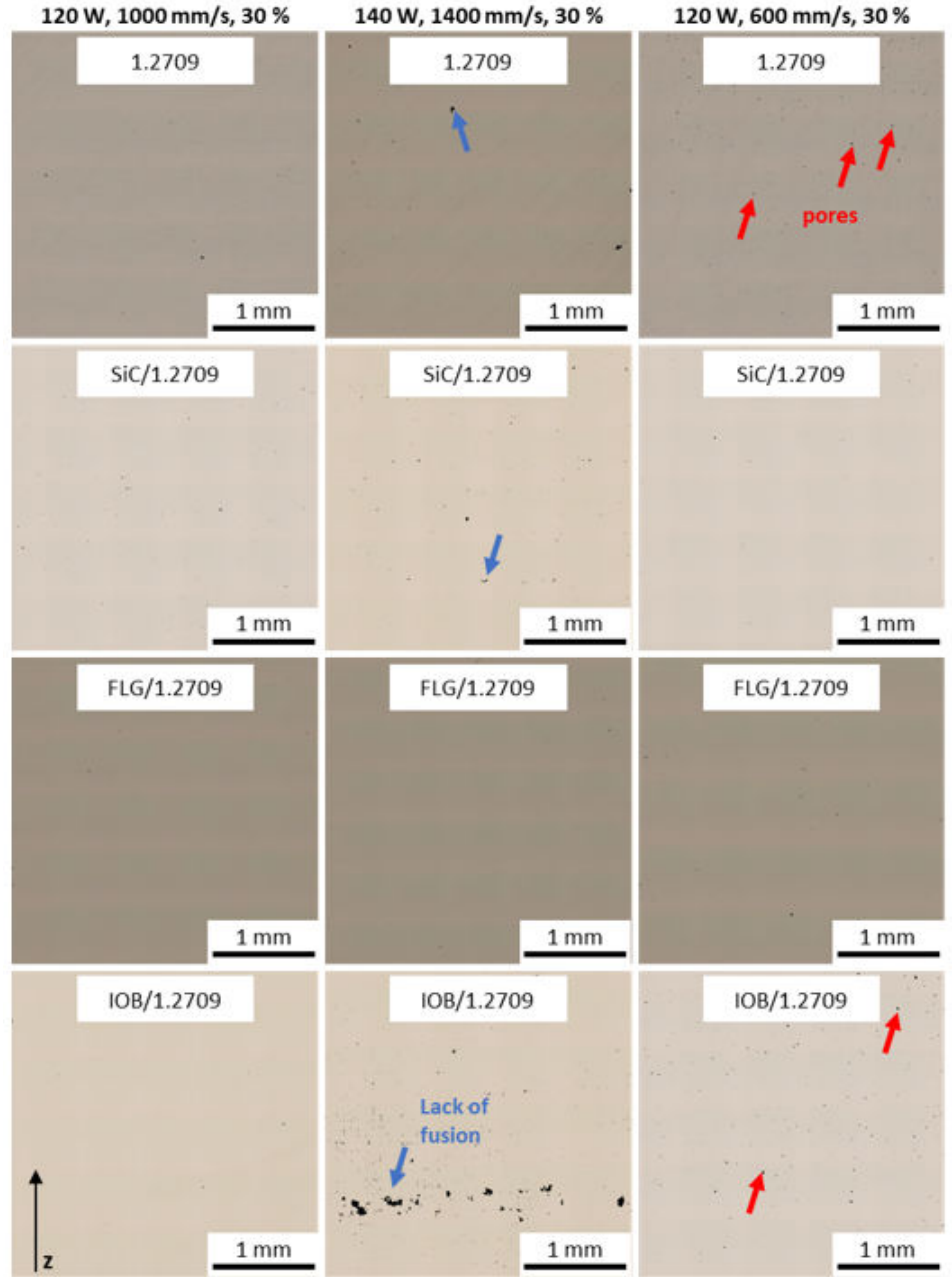
Figure 12. Cross-sections of manufactured specimens different process parameters and an overlap of 30%; pore formation indicated by red arrows; lack of fusion indicated by blue